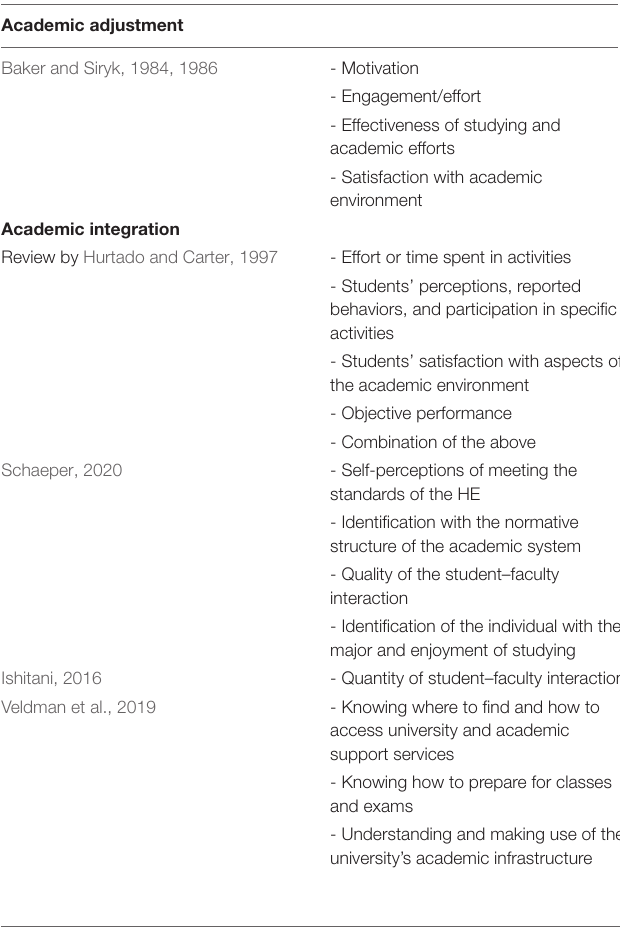
TABLE 1 | Summary of conceptualizations of academic adjustment and integration quoted in this